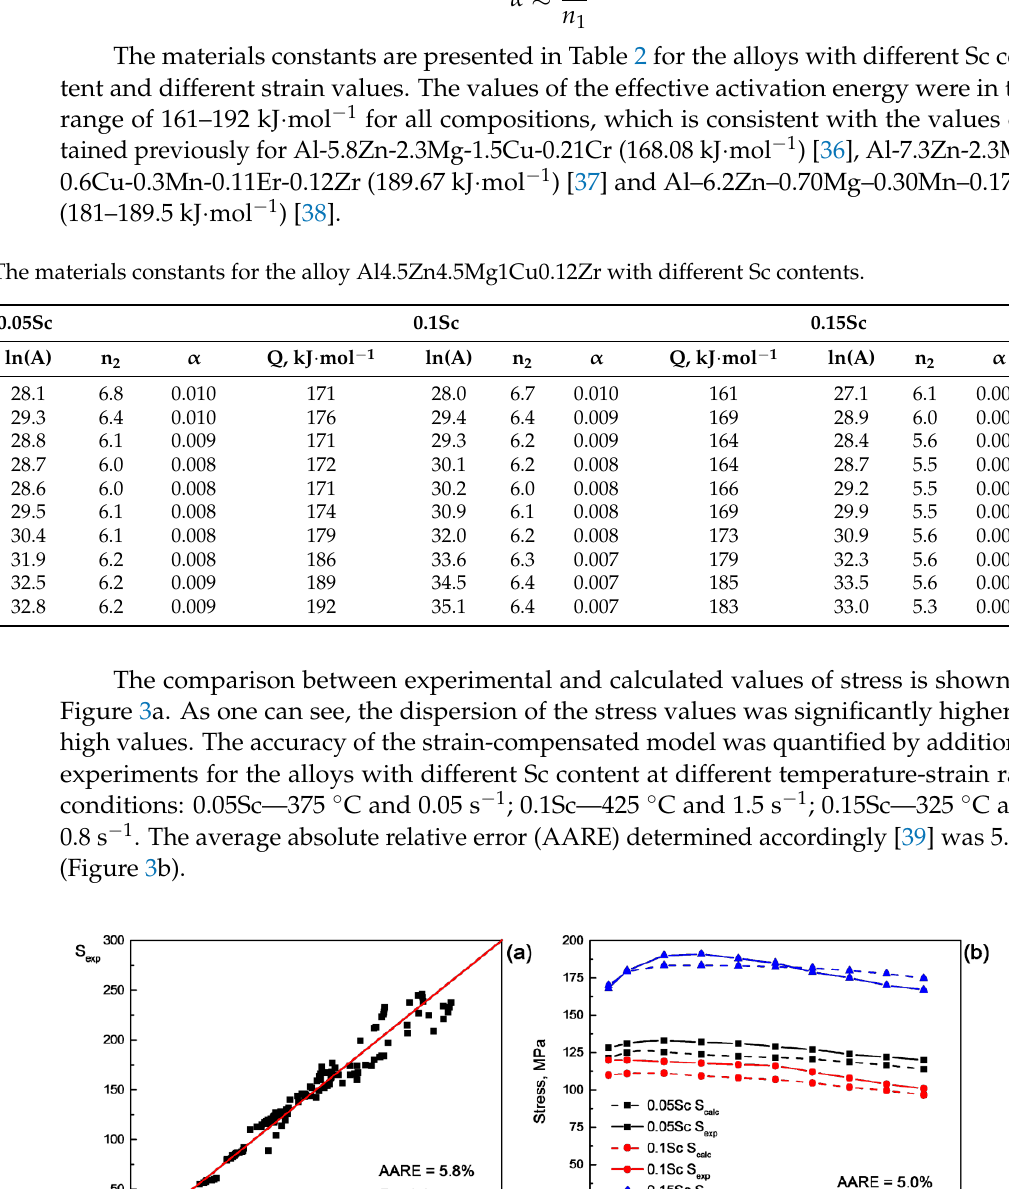
Table 2. The materials constants for the alloy Al4.5Zn4.5Mg1Cu0.12Zr with different Sc contents.